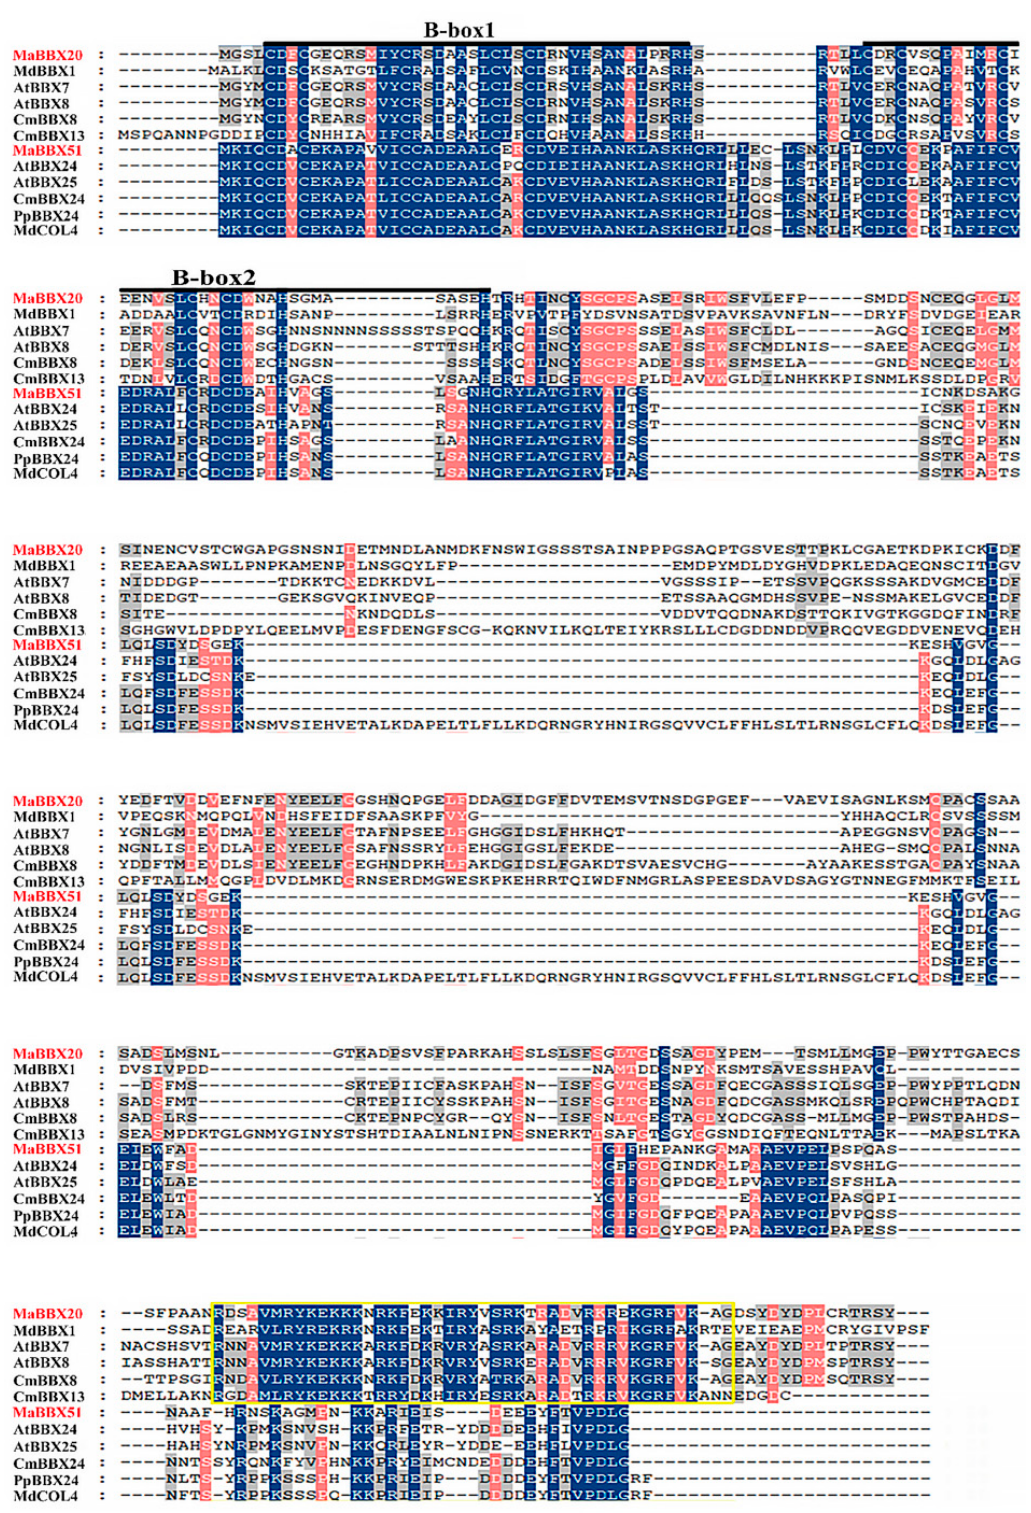
Figure 1. Multiple sequence alignment of MaBBX20, MaBBX51, and other BBXs. The alignment was generated using the GeneDoc software. Blue, pink, and grey columns indicate 100%, 80%, and 60% identity, respectively. The B-box and CCT domains are marked by dark lines and the yellow square, respectively. GeneBank accession numbers for all proteins are listed in Supplementary Table S2.